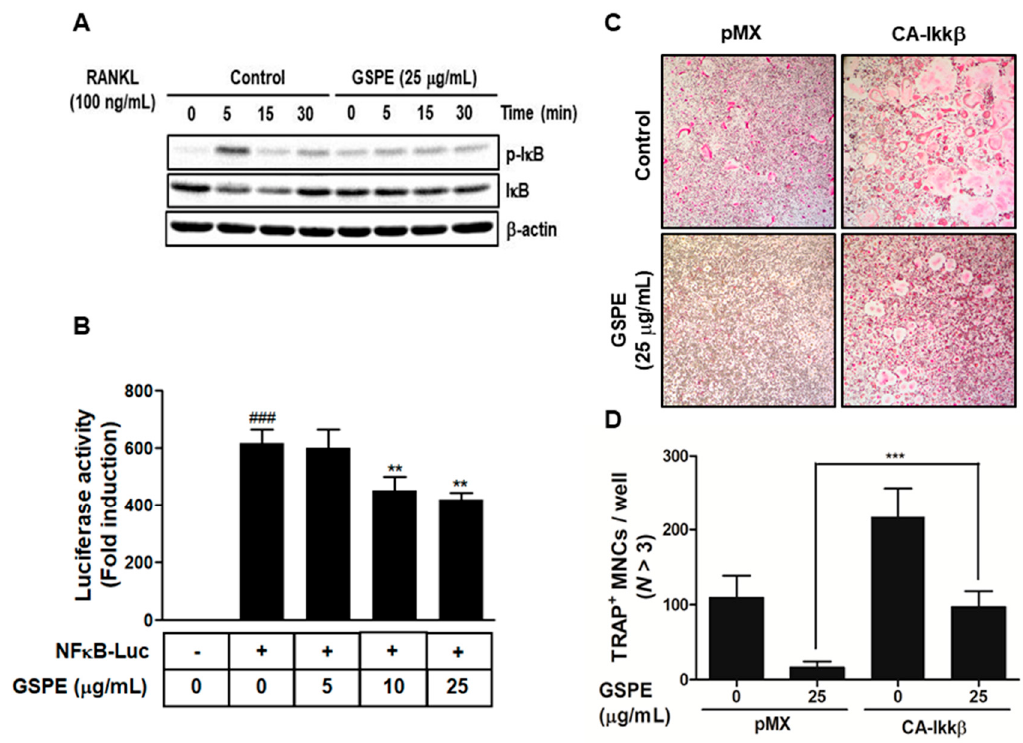
Figure 4. GSPE suppresses osteoclast differentiation by downregulating the NF- κ B signaling pathway. ( A ) Bone marrow macrophages ( BMMs ) were pretreated with 25 μ g/mL GSPE for 1 h in the presence of 10 ng/mL M-CSF, followed by stimulation with 100 ng/mL RANKL for the indicated time period. Western blot analysis of the whole-cell lysates was performed using phospho-I κ B and I κ B antibodies. β -actin served as the internal control. ( B ) HEK293R cells were co-transfected with an NF- κ B luciferase reporter and β -galactosidase to normalize the transfection efficiency. The transfected cells were incubated for 24 h in the presence of the indicated concentrations of GSPE. Luciferase activity has been expressed as the fold induction relative to the corresponding negative control condition. ### p < 0.001 versus negative control; ** p < 0.01 versus vehicle. ( C ) BMMs were infected with pMX-constitutively active (CA)-I κκβ -IRES-EGFP. Infected BMMs were pretreated with or without 25 μ g/mL GSPE in the presence of 30 ng/mL M-CSF for 24 h, followed by stimulation with 100 ng/mL RANKL. After 4 days, osteoclasts were detected using TRAP staining and ( D ) TRAP-positive MNCs were counted. *** p < 0.001 versus control. Abbreviations: GSPE, grape seed proanthocyanidin extract; RANKL, receptor activator of nuclear factor kappa- Β ligand; MNCs, multinucleated cells; NF- κ B-LUC, n uclear factor- κ B luciferase.